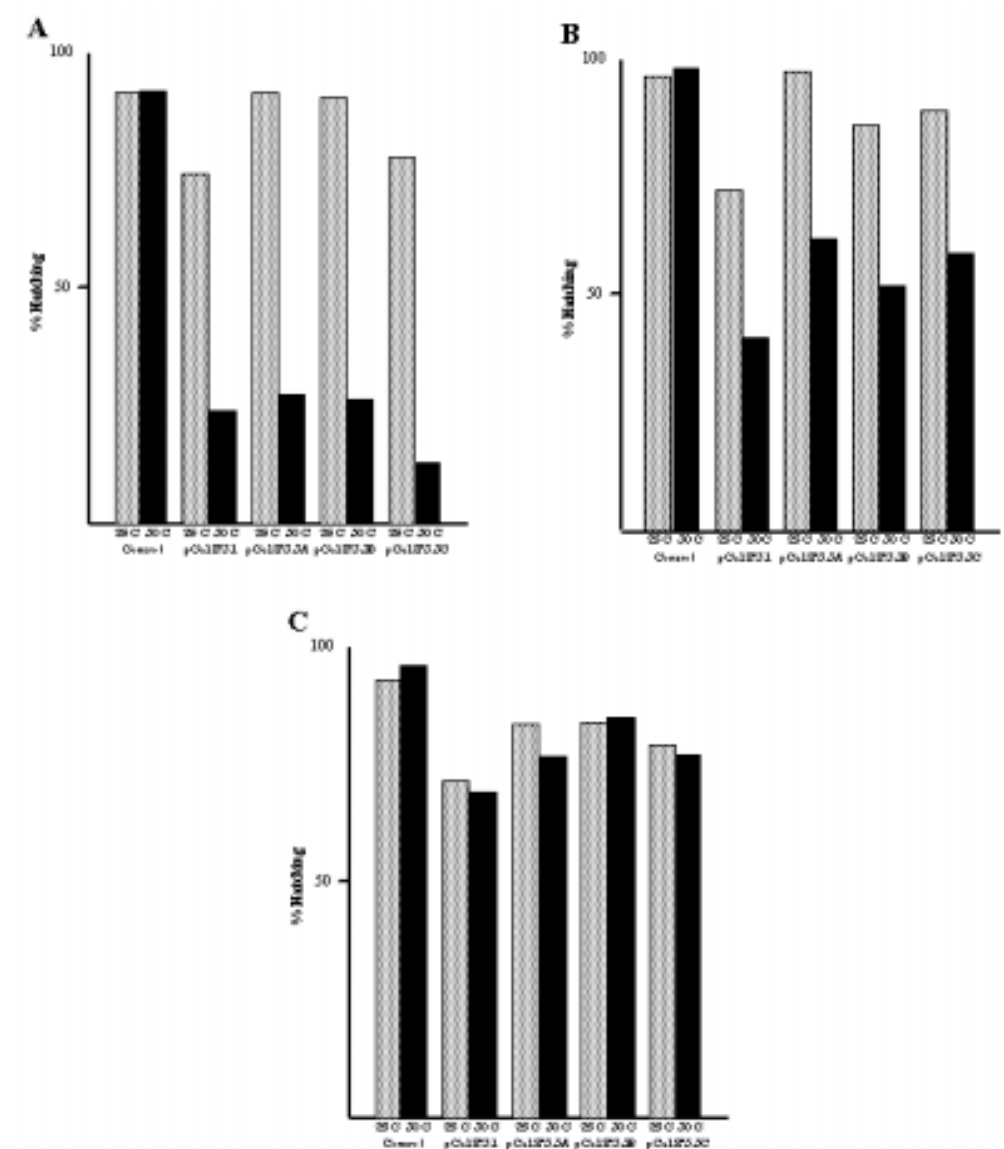
Fig. 2 – Percent hatching of embryos from the four pCa18 (cid:5) 3.1 transgenic lines after being heat shocked in different embryonic stages as described in methods. (A) 0-2h old embryos heat-shocked at 30 ◦ C for 8hs. (B) 8-10hs old embryos heat shocked at 30 ◦ C for 8hs. (C) 16-18h old embryos heat-shocked at 30 ◦ C for 8